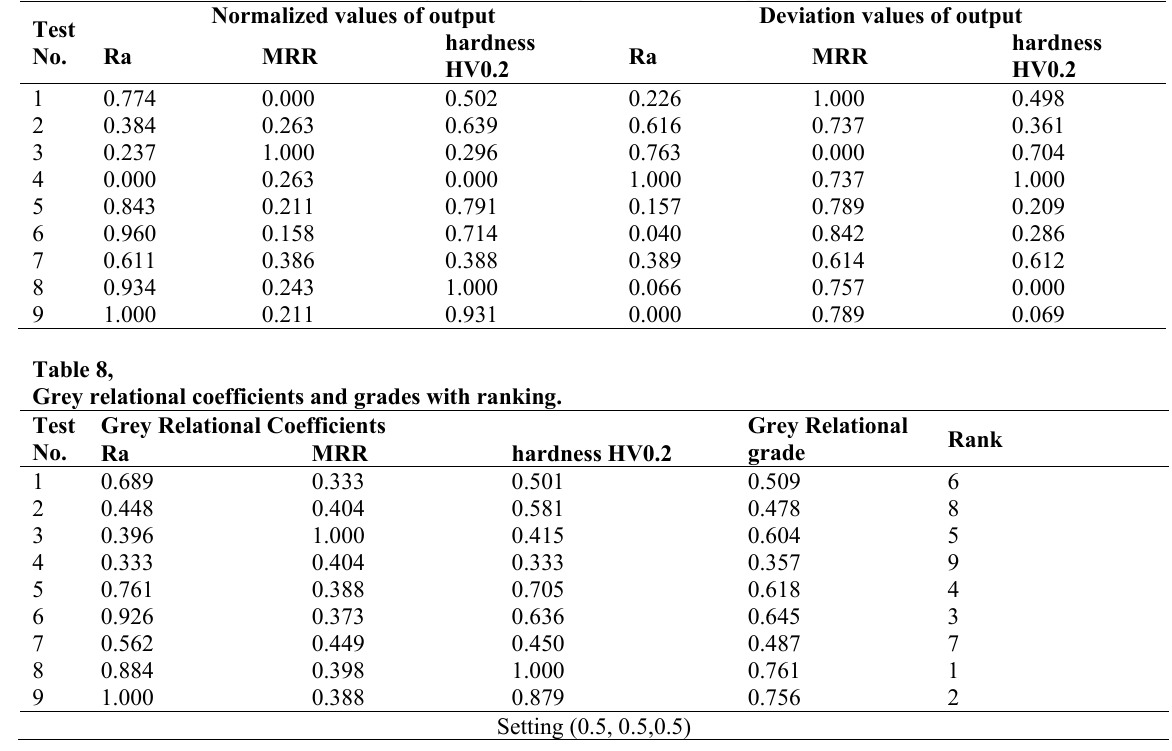
Normalized and deviation values from grey relational generation of output.